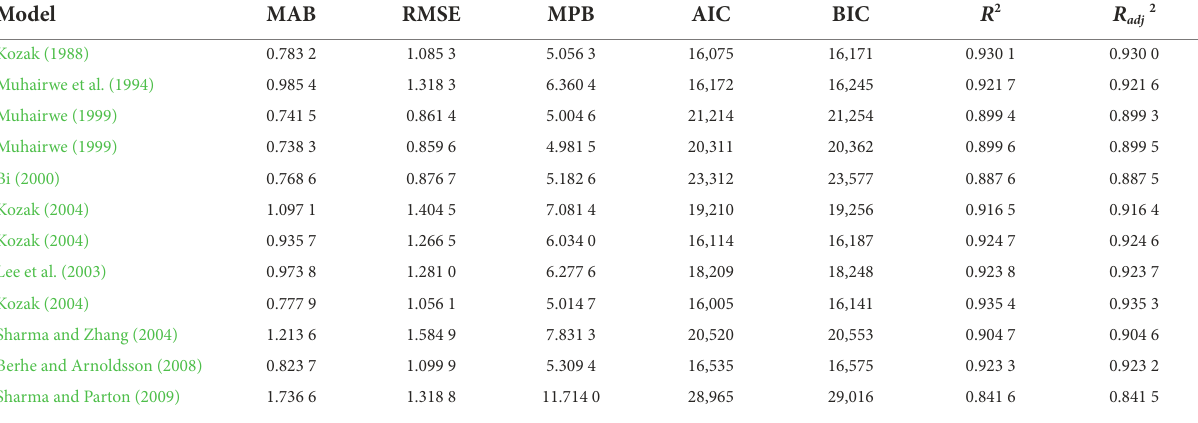
TABLE 4 Fit statistics of the 12 selected basic models. Model